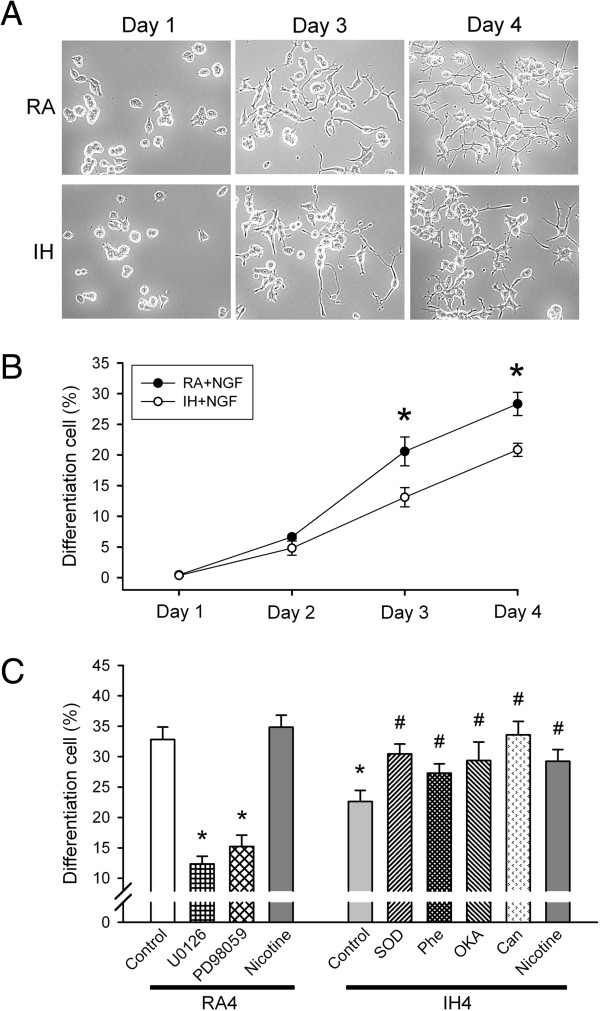
Effects of intermittent hypoxia (IH)-induced ROS generation on PP2A activation and downregulated ERK1/2 activation leading cell differentiation inhibition by nerve growth factor (NGF)-stimulated PC12 cells. (A) Images of neurite outgrowth using light microscopy and (B) percentages of differentiated cells among NGF-stimulated PC12 cells after 3–4 days of intermittent hypoxia (n = 5 for per group). (C) Percentages of differentiated cells among NGF-stimulated PC12 cells after exposure to normoxia for 4 days (RA4, control, n = 16), RA4 along with U0126 (n = 6) and PD98059 (n = 5) (ERK1/2 phosphorylation inhibitors), and nicotine (n = 10) (ERK1/2 phosphorylation inducer), and exposed to IH for 4 days (IH4, control, n = 14), IH4 along with superoxide dismutase (SOD, n = 8), 1,10-phenanthroline (Phe, n = 9), okadaic acid (OKA, n = 12) and cantharidin (Can, n = 5) (PP2A activation inhibitors), and nicotine (n = 7). *p < 0.05 compared with RA4. #p < 0.05 compared with IH4. Values are means ± SEMs.